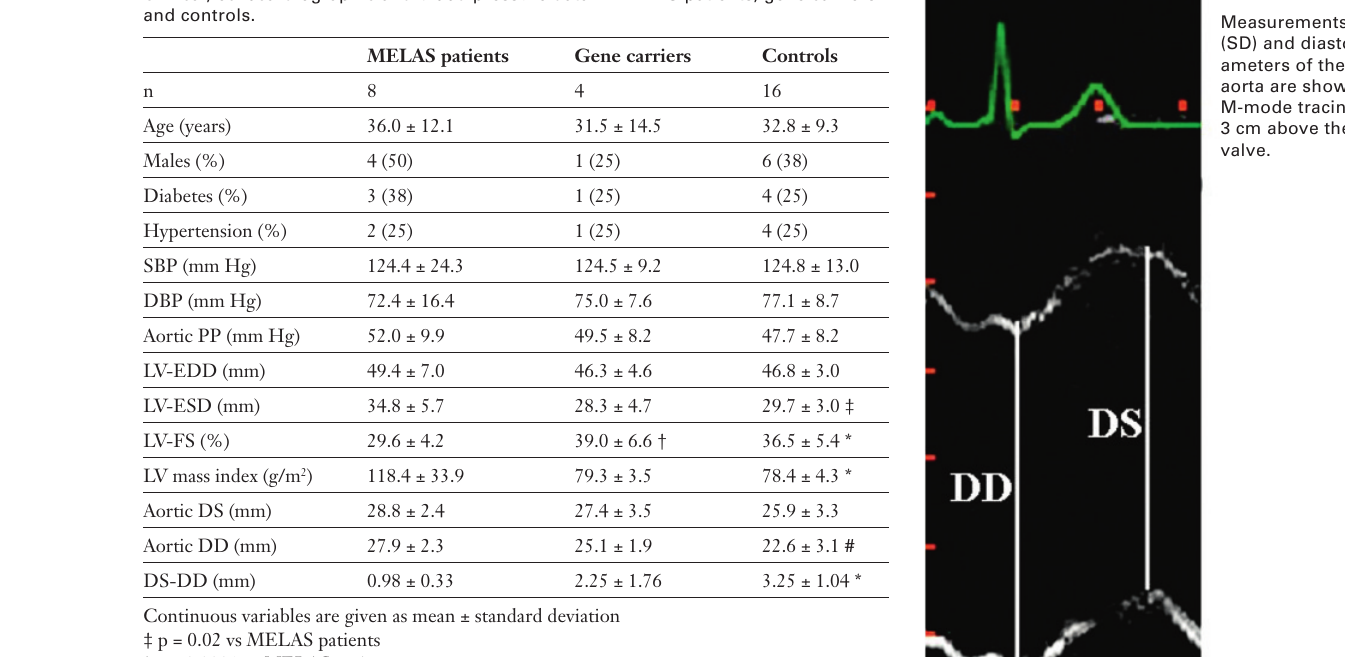
Clinical, echocardiographic and blood pressure data in MELAS patients, gene carriers and controls. Measurements of systolic